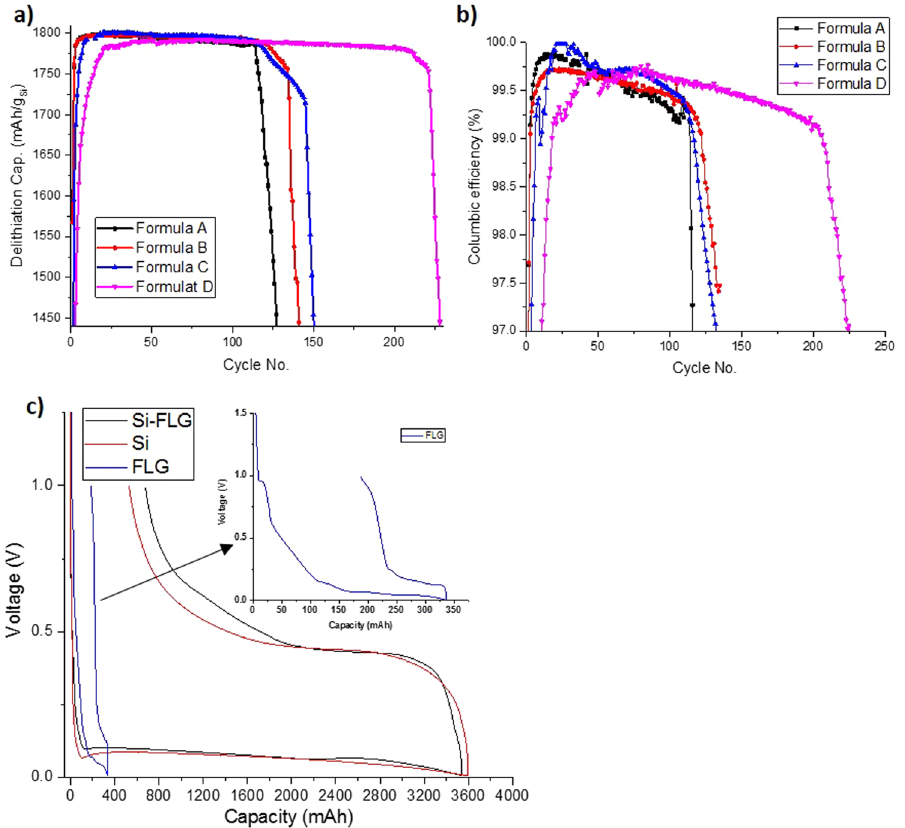
Figure 2. ( a ) Half-cell cyclability and ( b ) columbic delithiation efficiency under capacity limitation of 1800 mAh/g for Si-FLG formulation matrix (Formula A – 76% Si: 0% FLG: 12% Na-PAA: 12% Carbon.